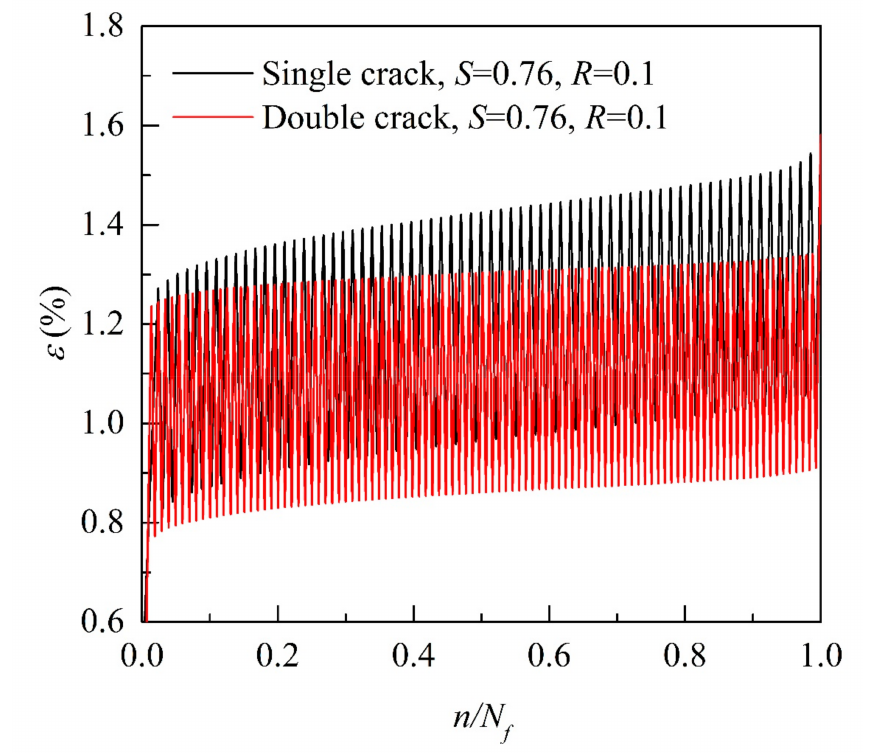
Figure 8. Strain-cycle ratio